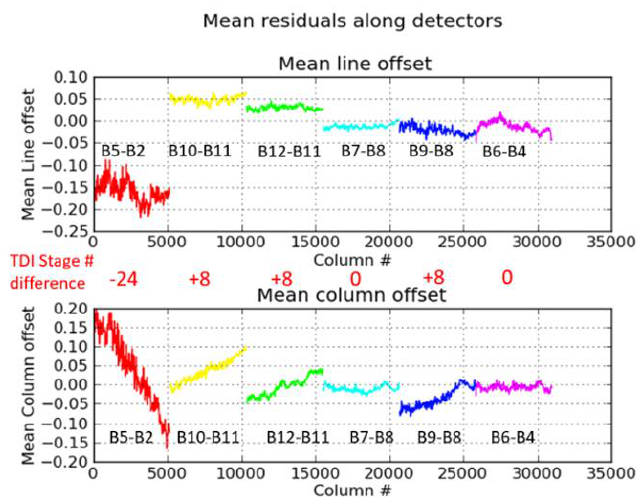
Figure 16. Inter-band registration residuals due to TDI mis-synchronization on a 30° pitch viewing angle VEN µ S image. Differential magnification between spectral bands is clearly proportional to TDI stage number difference.